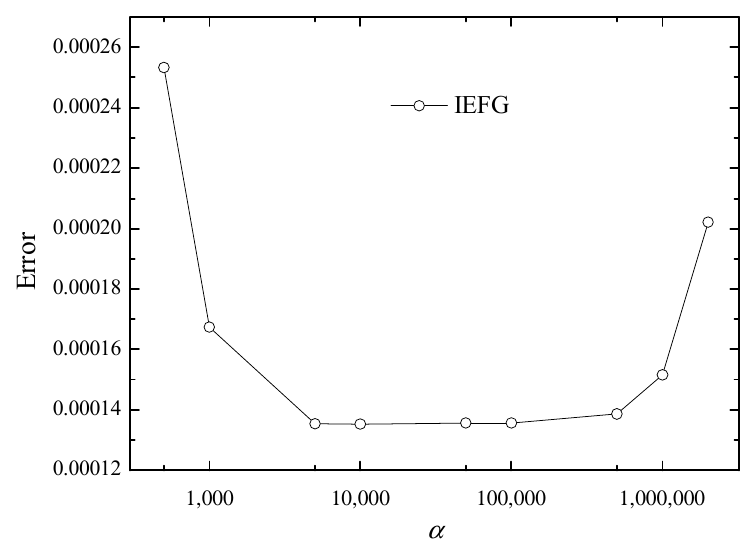
Figure 2. The relationship between α and the relative error.